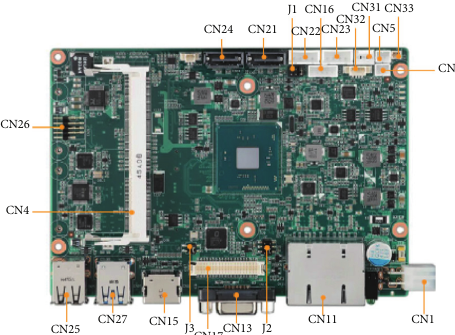
Figure 2: Advantech PCM9310 module for upper computer.